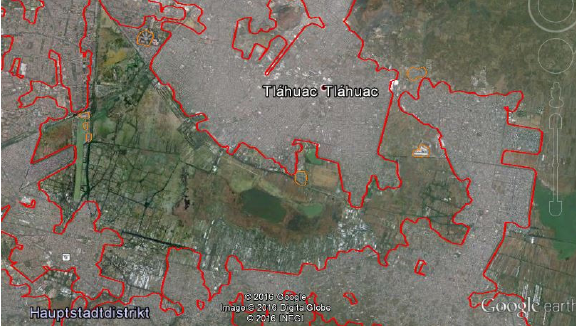
Figure 18. Evaluation of area (2) by Google Earth (with images